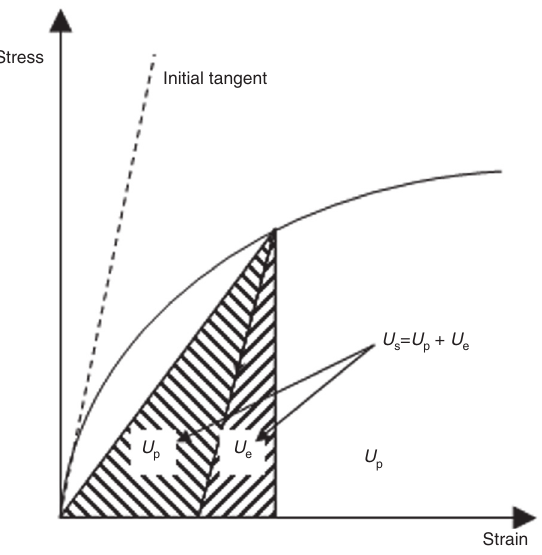
Figure 10 Typical nonlinear stress-strain curve for the i th mechani- cal property showing the strain energy density terms.